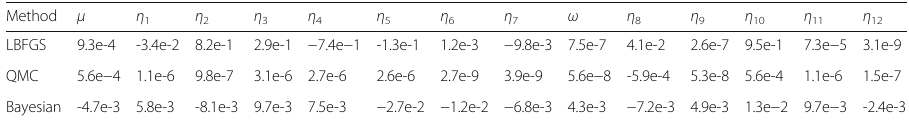
Table 3 The GARCH parameters for the PET sector